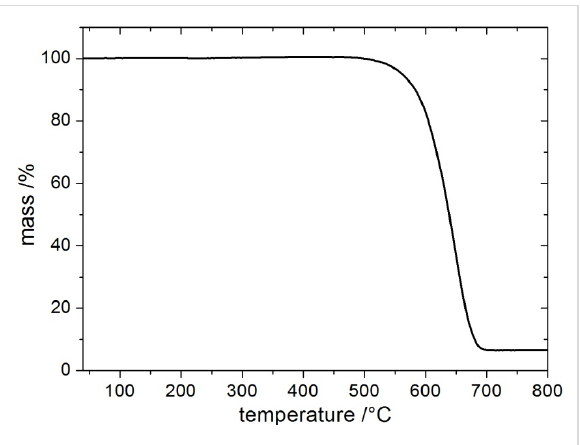
Figure 5: Thermogravimetric plot of the decomposition of the carbon tubes ( 4 ) carbonized at 950 °C in air.